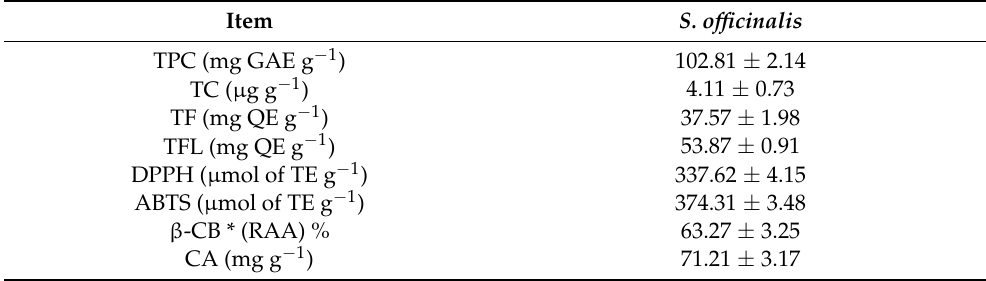
Table 1. Total phenolic content, total carotenoids, total flavonoids, total flavonols, and relative potential antioxidant activities of S. officinalis leaves (mean ± SE), n = 6. Item S.